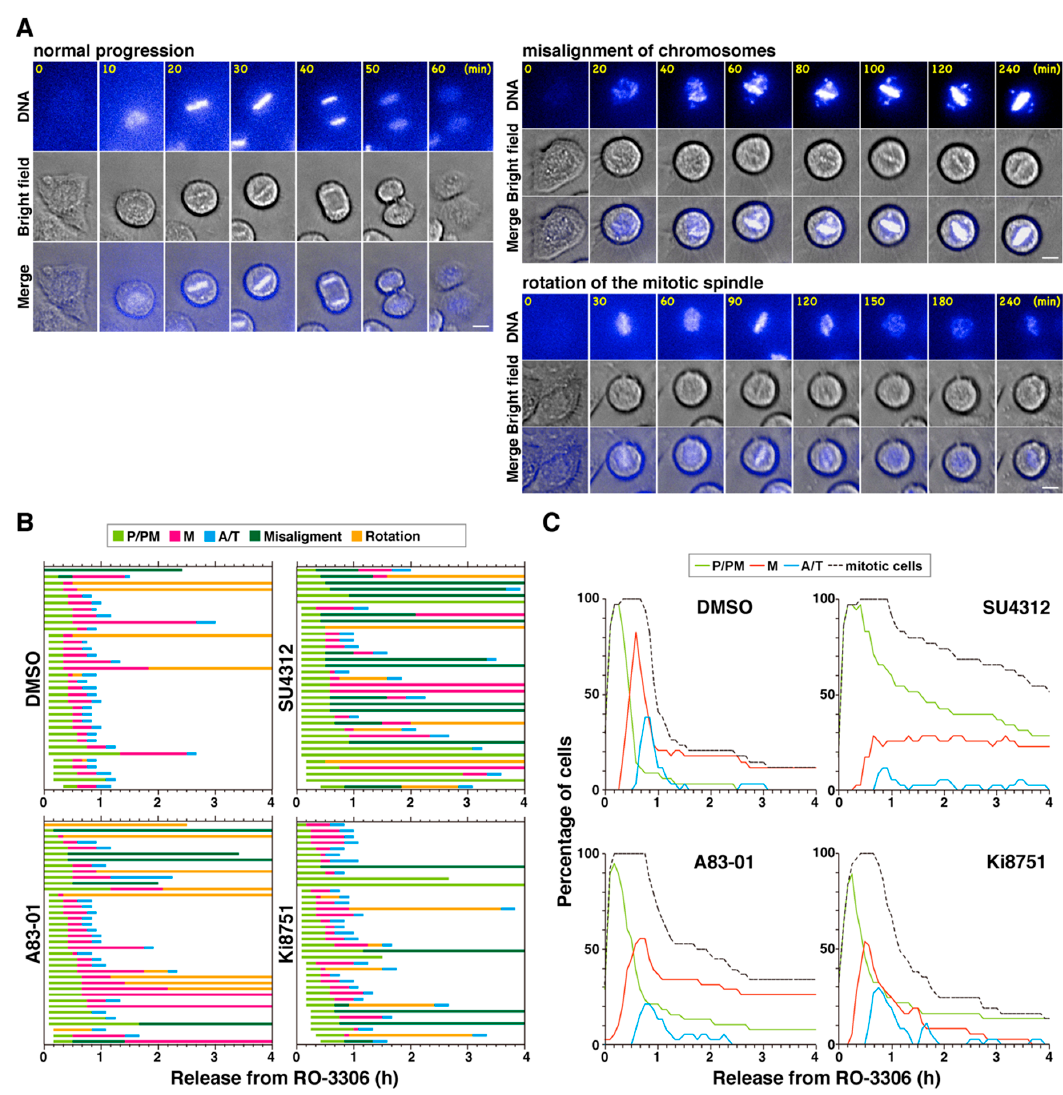
Figure 4. VEGFR inhibitors cause aberrant M phase progression. Cells were treated with 6 µM RO-3306 for 20 h and released in the presence of DMSO, 3 µM A83-01, 10 µM SU4312, or 1 µM Ki8751, together with 0.1 µM Hoechst 33342 to visualize DNA. Mitotic progression was monitored every 5 min for 3 h by time-lapse imaging. ( A ) Representative images of cells exhibiting normal M phase progression, misalignment of chromosomes, and rotation of the mitotic spindle are shown. Scale bars, 10 µm. ( B ) Based on the time-lapse images shown in ( A ), the duration of each mitotic phase (prophase and prometaphase(P/PM, light green), metaphase (M, red), anaphase and telophase (A/T, blue)), misalignment of chromosomes (deep green), and rotation of the mitotic spindle (orange) in individual cells are shown (DMSO, n = 34; A83-01, n = 38; SU4312, n = 35; Ki8751, n = 37). ( C ) The percentages of mitotic cells (black), cells in prophase and prometaphase (P/PM, green), metaphase (M, red), and anaphase and telophase (A/T, blue) at the indicated times are shown. M phase progression is divided into three steps: P/PM, M, and A/T, and the time taken for each cell to complete this progression is shown in Figure 4B. Two aberrant phenotypes are also indicated: misalignment of chromosomes (deep green) and rotation of the mitotic spindle (orange). Most control cells completed cell division within 90 min (~80%, n = 34). Treatment of cells with the VEGFR inhibitors consistently delayed M phase progression; 53%, 82%, and 30% of cells took more than 90 min to complete cell division after treatment with A83-01, SU4312, and Ki8751, respectively. In approximately 85% of control cells, chromosomes were aligned at the cell equator within 30 min from